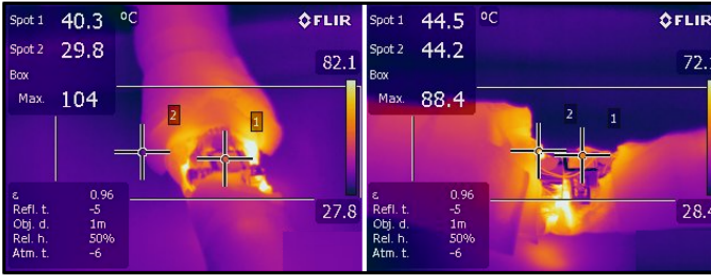
Figure 18. Infrared image of the used MJPV solar cell.